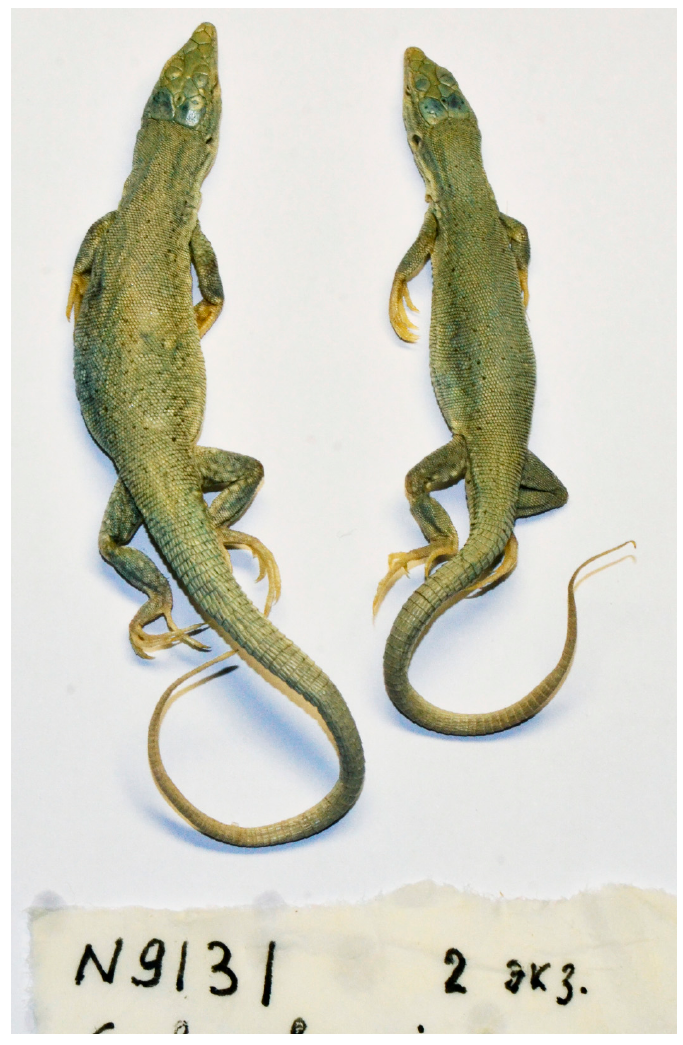
Figure 5. Historical specimens of E. buechneri (ZISP 9131) in preservative in dorsal view.